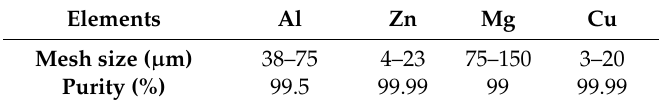
Table 1. Specifications of raw